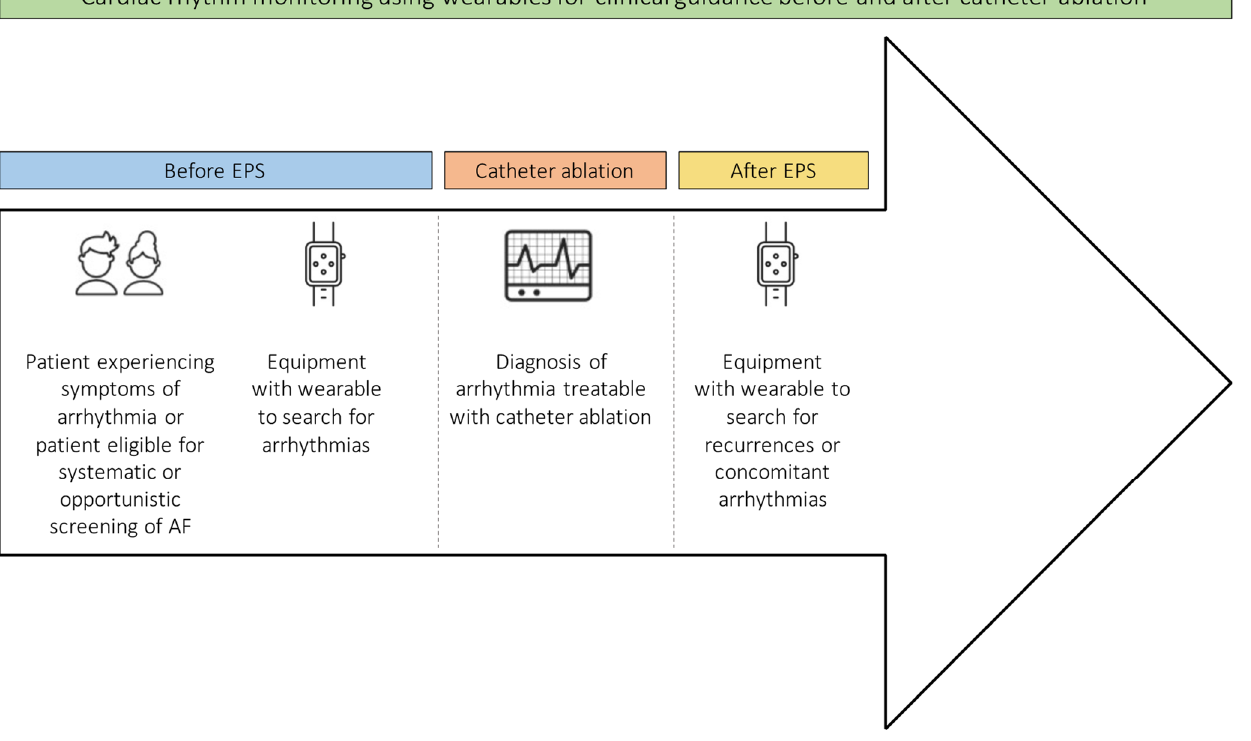
Figure 4. Cardiac rhythm monitoring using wearables for clinical guidance before and after catheter ablation. EPS = electrophysiological study; AF = atrial fibrillation.